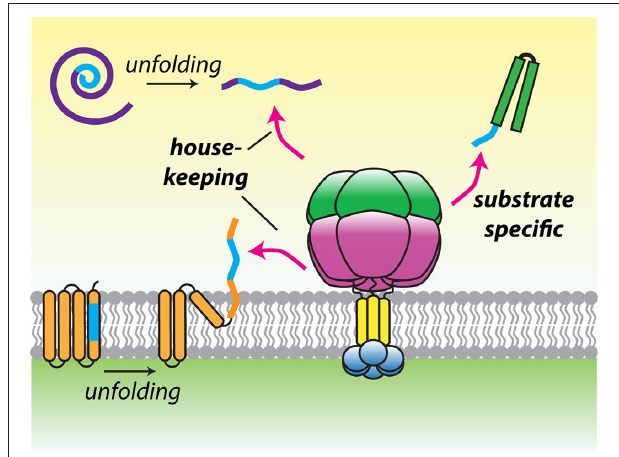
FIGURE 3 | A model for substrate recognition by hydrophobic degrons. Hydrophobic recognition sequences (blue) may be found in transmembrane segments or hydrophobic cores of proteins that become exposed after damage induced folding. Alternatively, degrons may be present at the termini of substrates to promote constitutive recognition and degradation. This recognition logic could allow the mitochondrial AAA proteases to operate both as house-keeping and selective